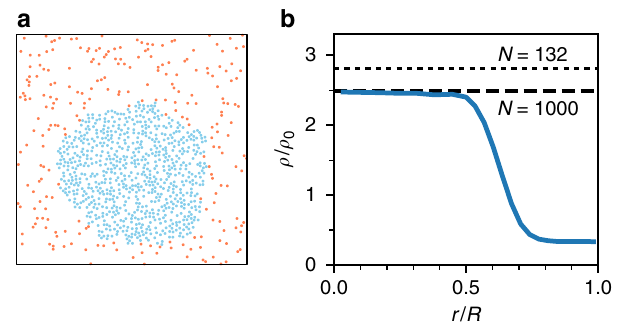
Fig. 8 Cluster formation with periodic boundary conditions. a Snapshot of a simulation with N = 1000 particles with density ρ 0 = 0.0075 μ m − 2 ( λ = 5 σ , c = 5.5 ~ c ). As in the con fi ned system, we observe the formation of a th cluster of non-motile particles (blue) surrounded by a dilute gas of motile particles (red). b Blue: Corresponding radial density pro fi le ρ ( r )/ ρ 0 (with respect to the particles ’ centre of mass) with R half the box length. The cluster density is the same as for a circularly con fi ned system with N = 1000 particles at the same density (dashed line). For the smaller system with N = 132, the cluster density is slightly higher (dotted line). The reason is that due to the smaller con fi nement, quorum concentrations are lower and thus the particles have to form a denser cluster to overcome the